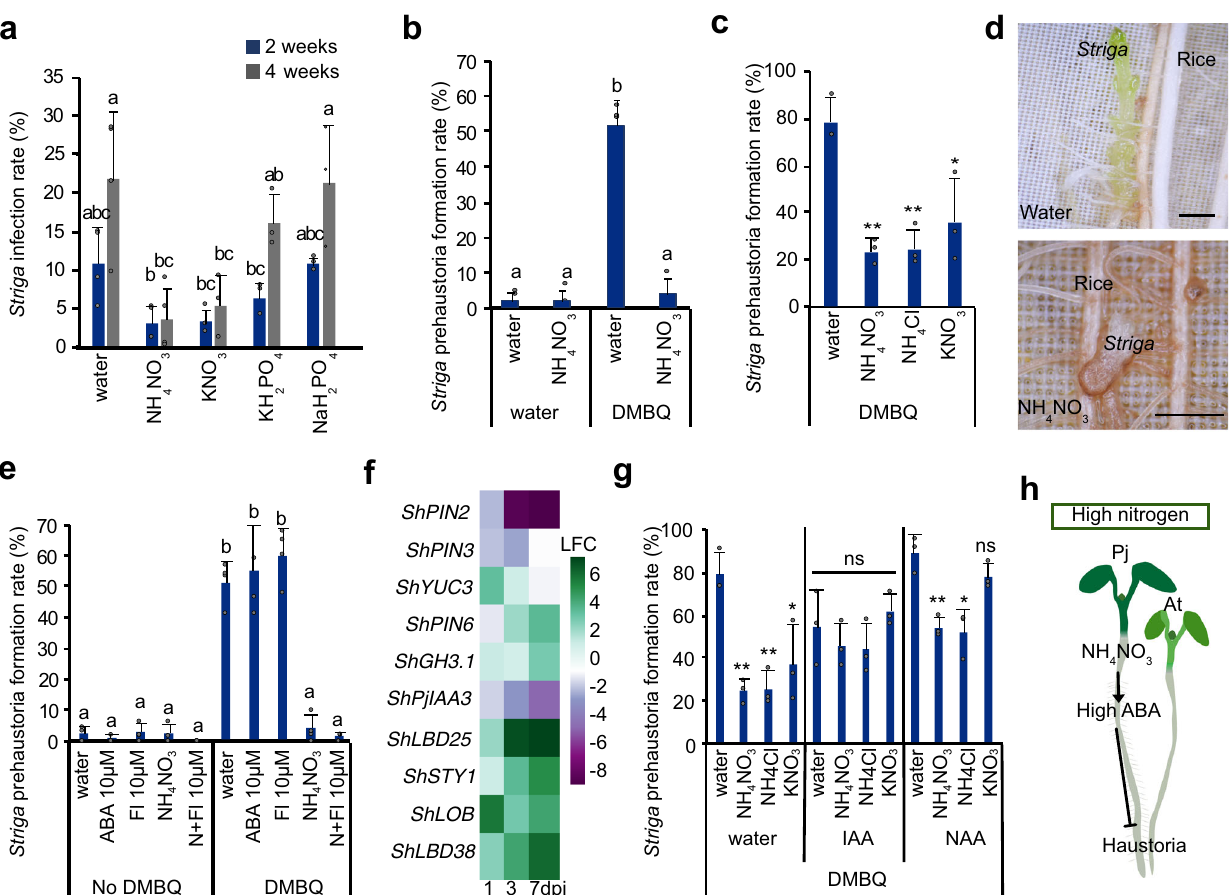
Fig. 7 Nitrogen inhibits Striga infection rates. a Striga infection rate of rice at 2 and 4 weeks with 20.6 mM KNO 3 , 10.3 mM NH 4 NO 3 , 0.62 mM KH 2 PO 4 or 1.9 mM NaH 2 PO 4 (mean ± SD, n = 8 plants per treatment, 3 replicates). b Effect of 10.3 mM NH 4 NO 3 on Striga prehaustorium formation induced by 10 μ M DMBQ (mean ± SD, n = 8 per treatment, 3 replicates). c Effect of 10.3 mM NH 4 NO 3 , 10.3 mM NH 4 Cl and 29.5 mM KNO 3 on Striga prehaustorium formation induced by 10 μ M DMBQ (mean ± SD, n = 8 plants per treatment, 3 replicates). (d) Representative images of Striga infecting rice at 2